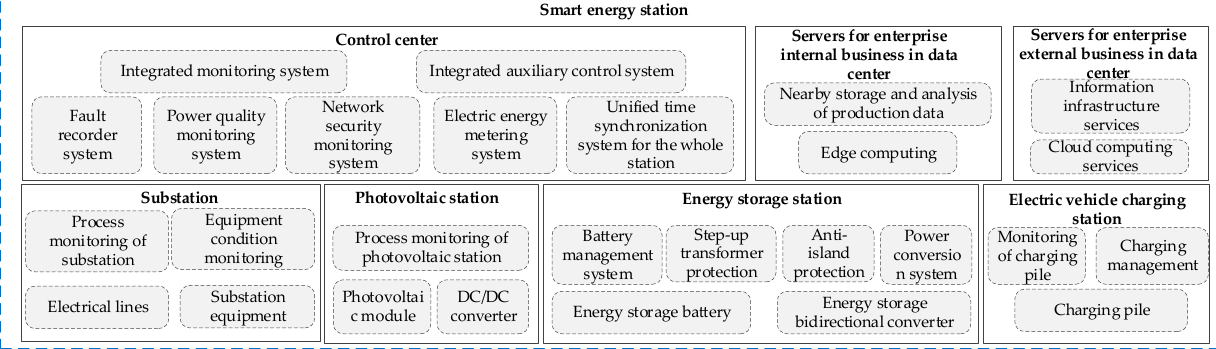
Figure 1. Composition of SESt.